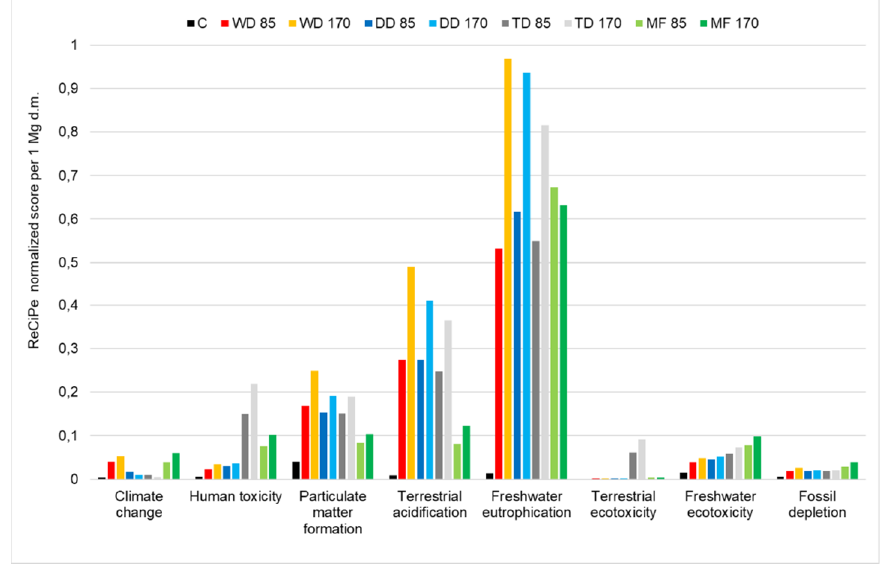
Figure 11. Normalisation scores for giant miscanthus production with the ReCiPe method (hierarchical version with European normalisation).